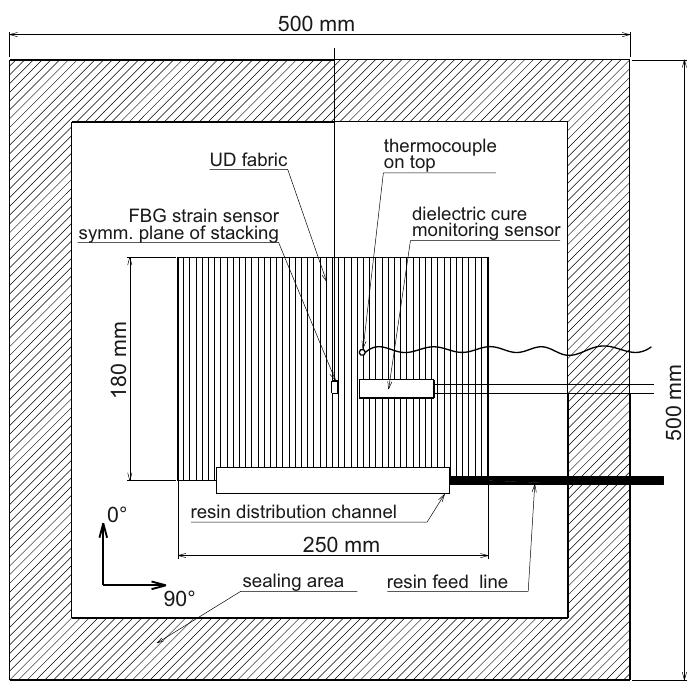
Figure 1. Sketch of the experimental set-up.